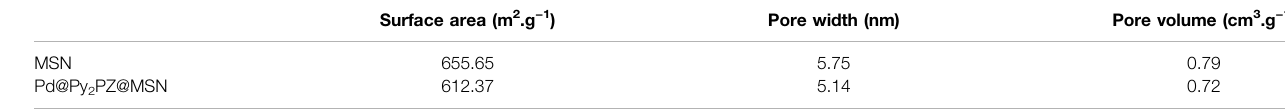
TABLE 1 | Surface area and pore size results of MSN and the Pd@Py 2 PZ@MSN catalyst. Surface area (m 2 .g − 1 )